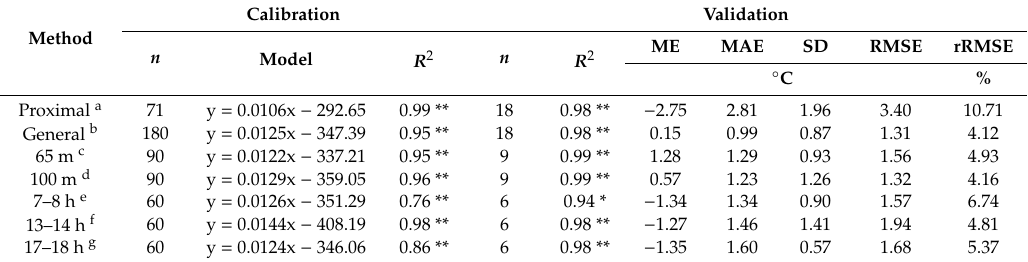
Table 6. Cross-validation results between the DN values of orthomosaics and the ground